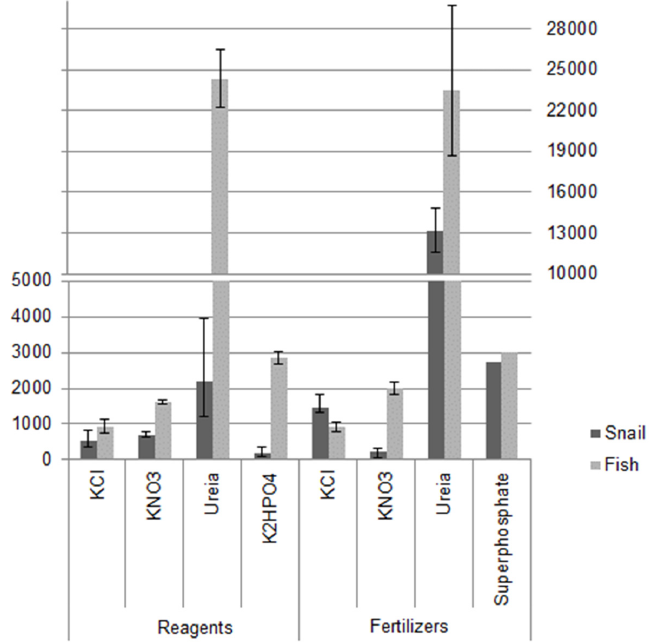
Figure 1. Lethal concentrations (LC50s) found for B. glabrata snail and D. rerio fish within 96 h of exposure (units: mg ∙ L − 1 ). Error bars represent 95% confidence intervals.